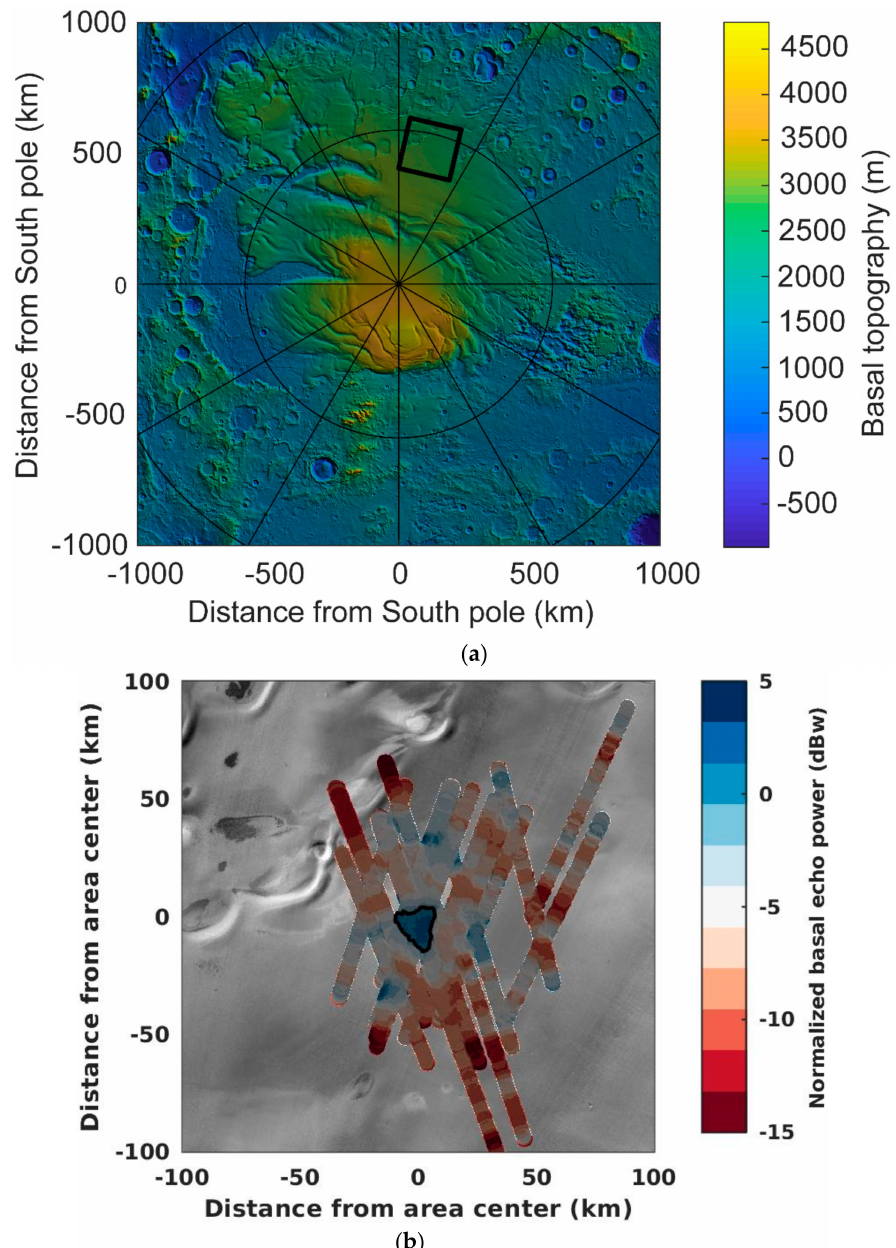
Figure 4. ( a ) Topographic map of the Martian South pole with the 200-km studied area in the Planum Australe enclosed by the contoured black line. ( b ) Spatial distribution of the power ratio P b / P s in the studied area. The contoured white line defines the basal bright area (highest intensity in dark blue